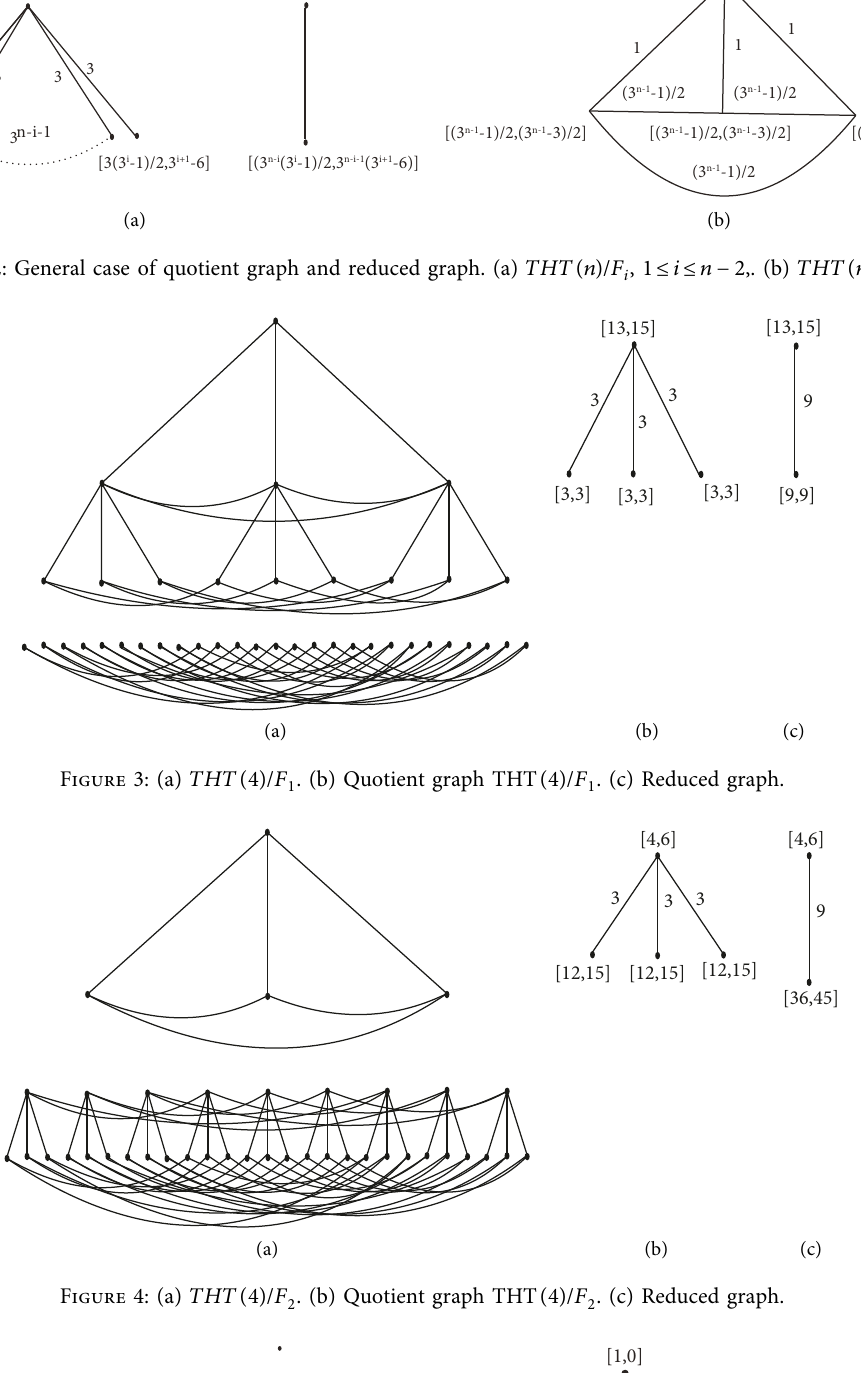
. (b) Quotient graph THT ( 4 ) / F 2